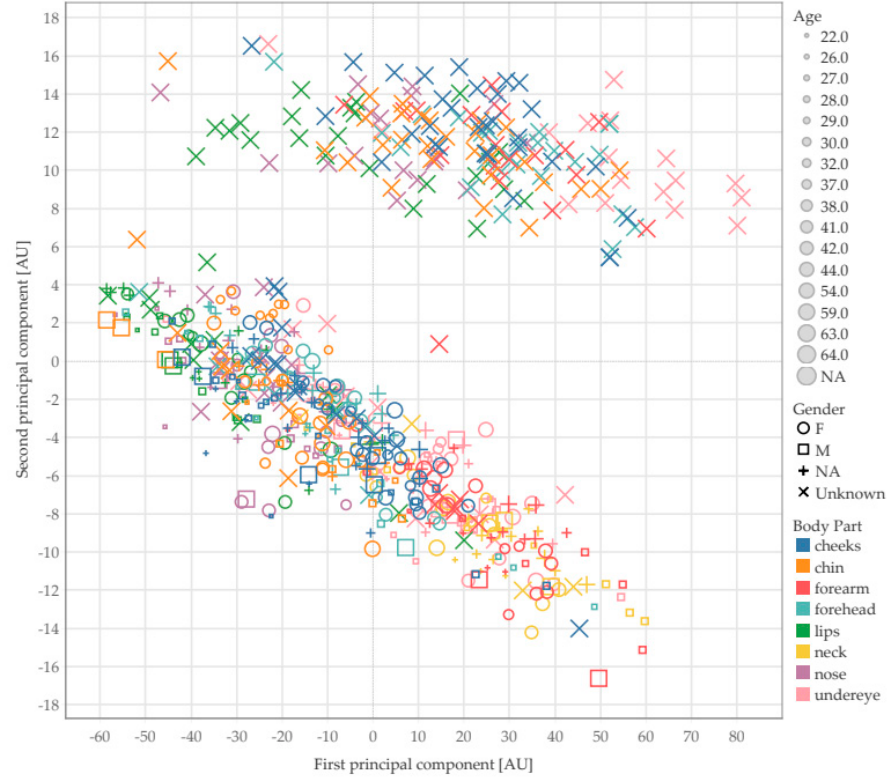
Figure 8. Scatter plot of the first two principal components from texture features computed through Gabor filters. Marker color shows details about the body part where the scan was taken; marker size and shape show, respectively, the age and gender of the subject. AU = arbitrary units.